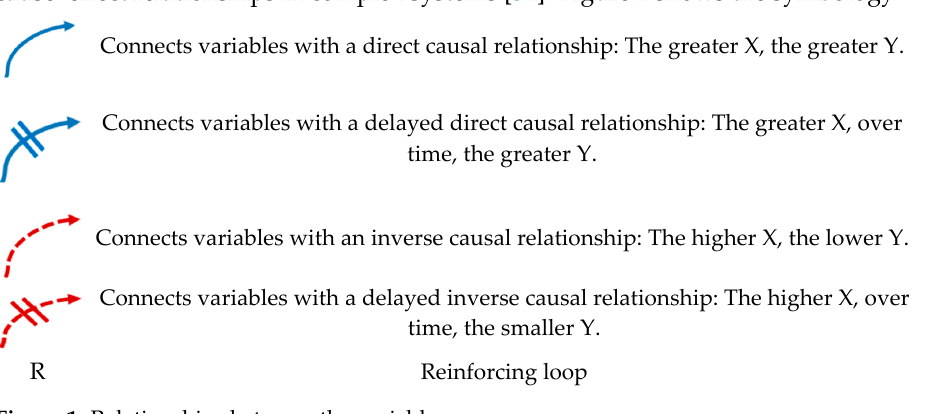
Figure 1. Relationships between the variables.